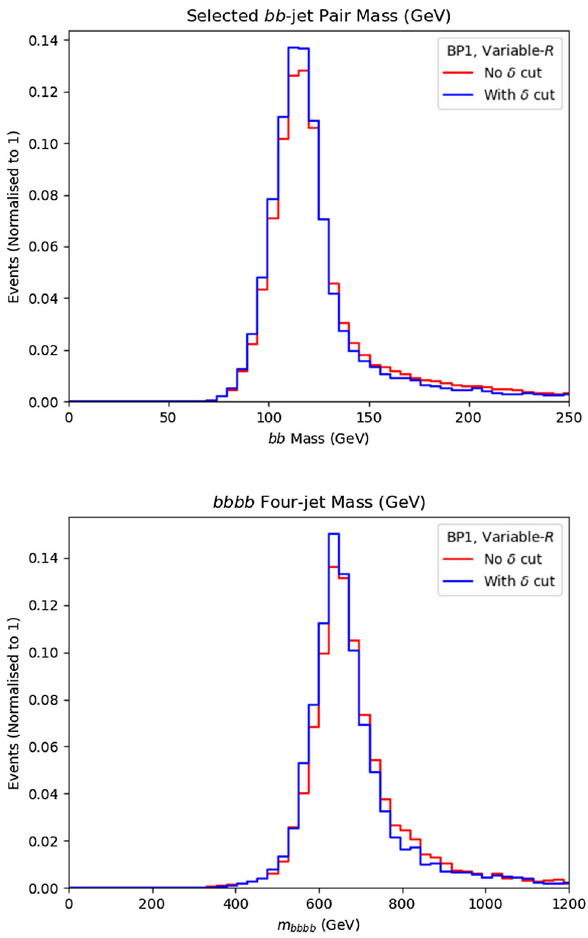
Fig. 13 Upper panel: the b -dijet invariant masses for BP2, with and without the addition of jet quality cuts as defined in Eqs. (5)–(6). Lower panel:thefour b -jetinvariantmass.Herewehaveusedavalueof δ = 0 . 1 for BP2